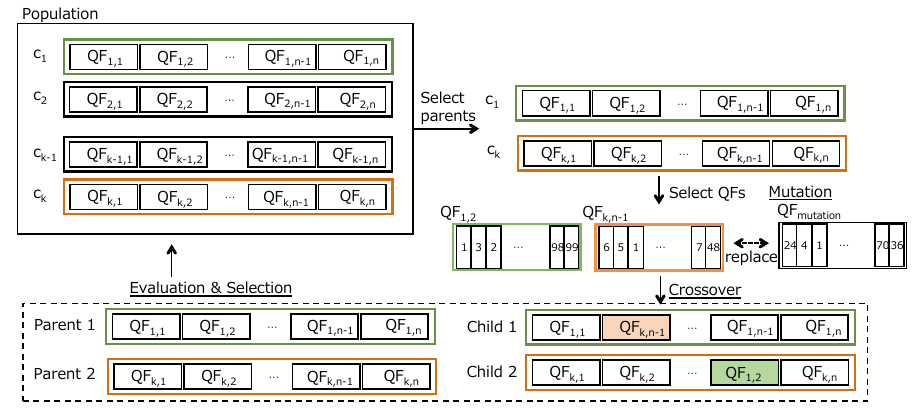
Figure 8. An example of our mutation and